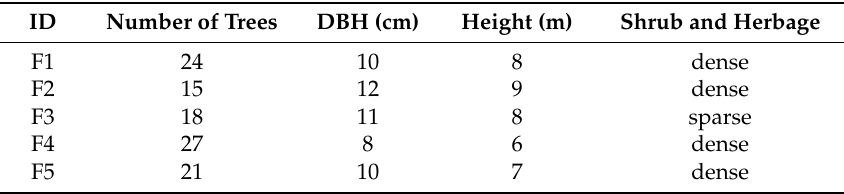
Table 1. Description of Terrestrial Laser Scanning (TLS)